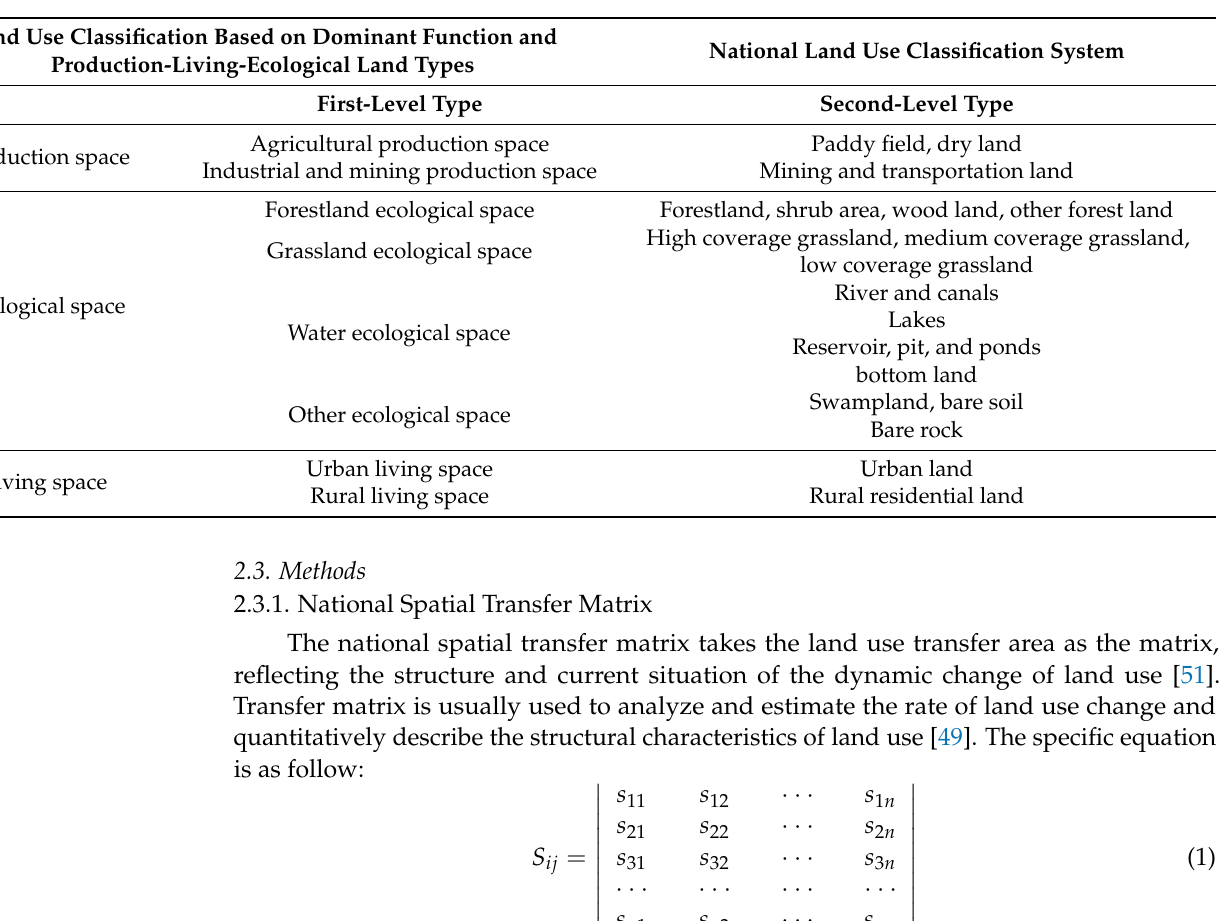
Table 1. Land use types based on dominant